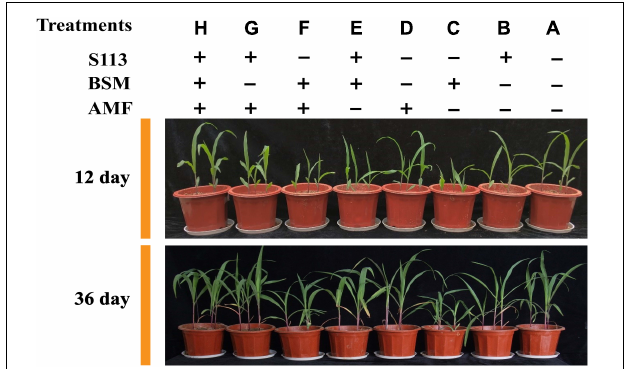
FIGURE 5 | The growth of maize under different treatments. (A) control (CK); (B) S113; (C) Bensulfuron-methyl (BSM); (D) Arbuscular mycorrhizal fungi (AMF); (E) S113 + BSM; (F) AMF + BSM; (G) S113 + AMF; (H) S113 + AMF + BSM. + : addition; − : without